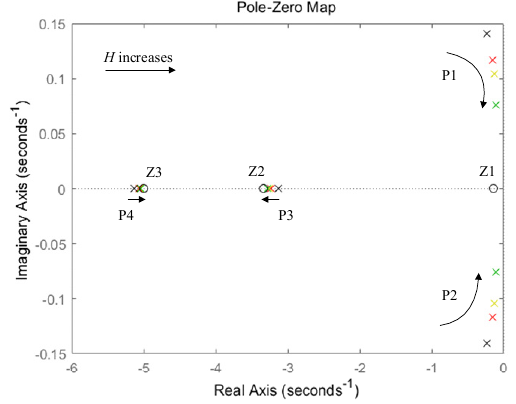
Figure 3. Pole-zero map of the transfer function.